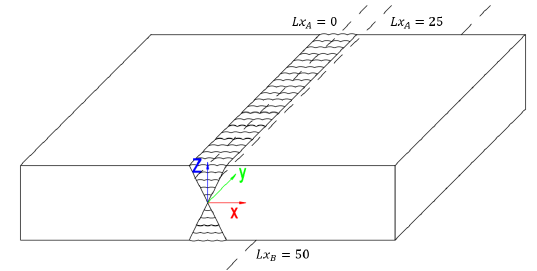
Figure 26. The longitudinal paths (unit mm).